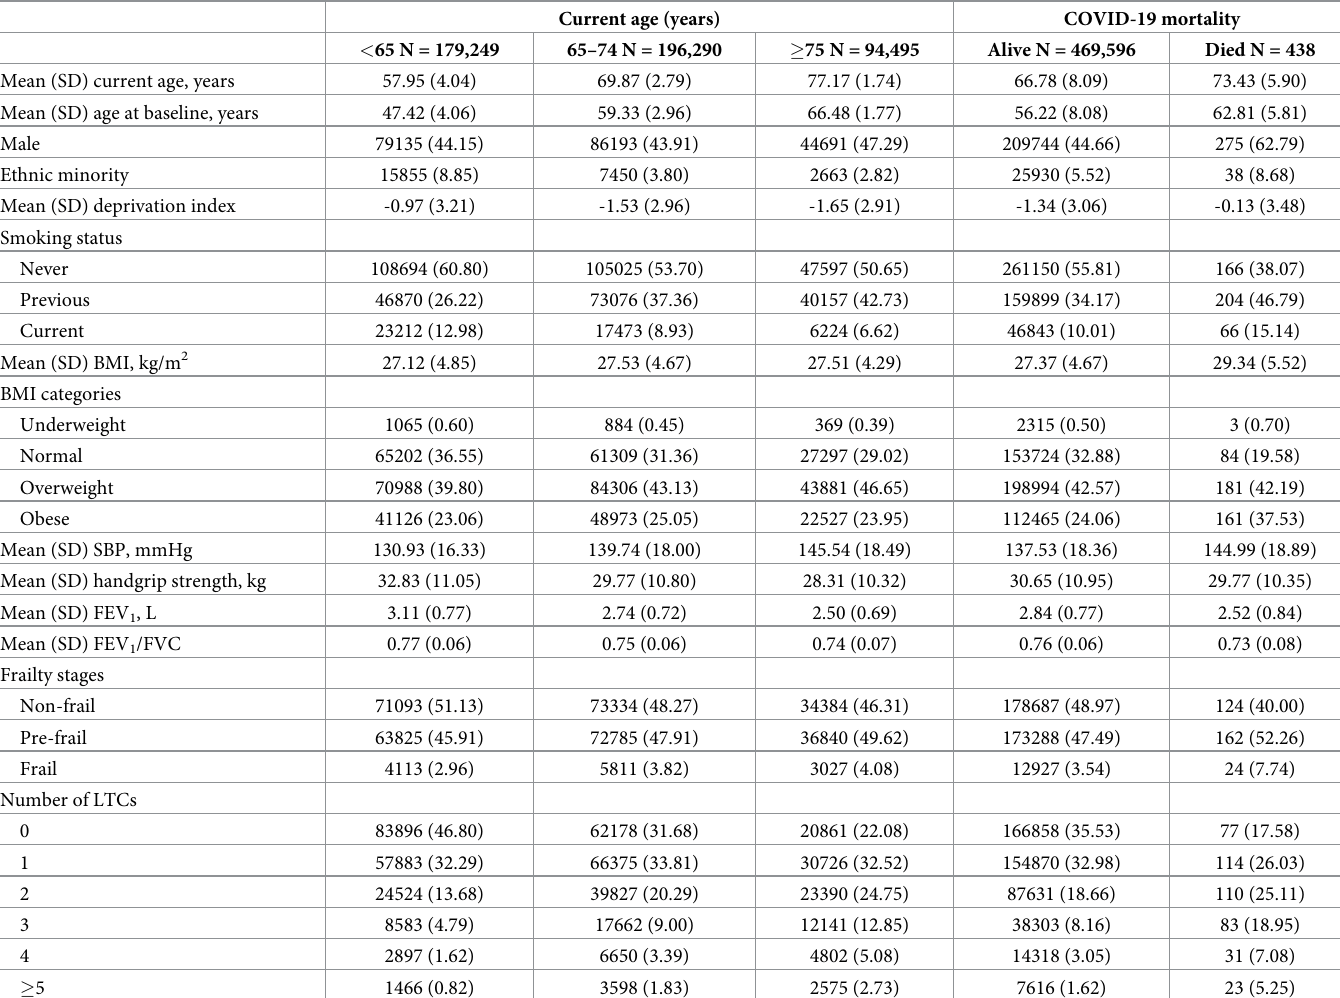
Table 1. Participant characteristics.